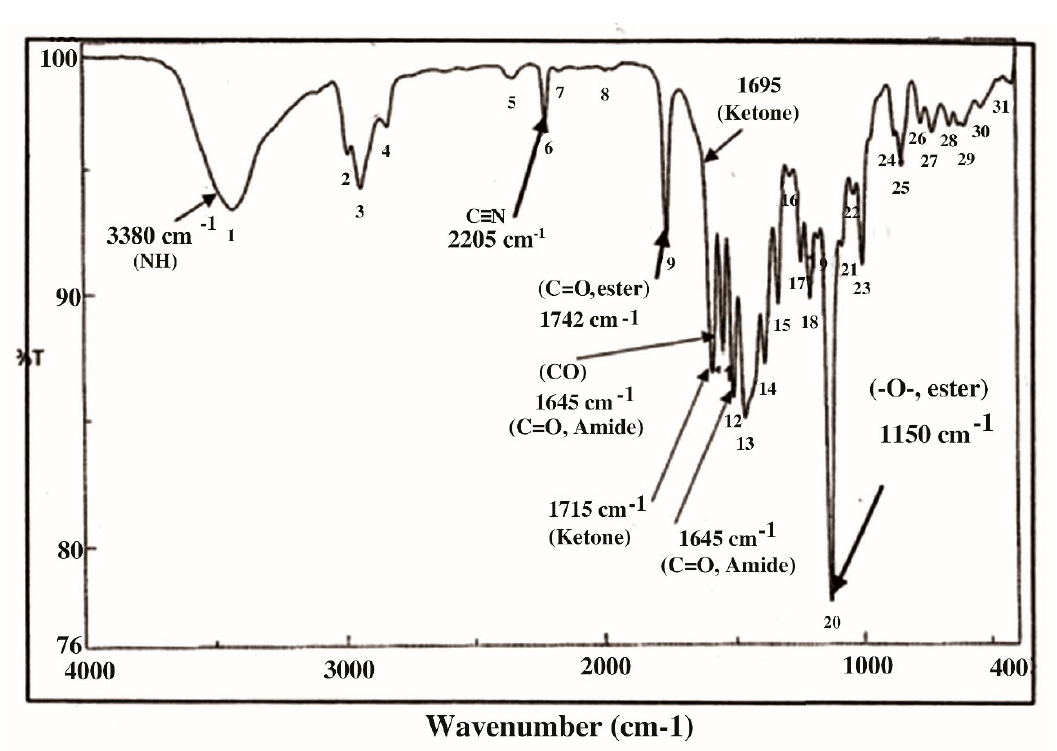
Figure 2. IR spectrum in KBr (discs) for the extraction of KFB.